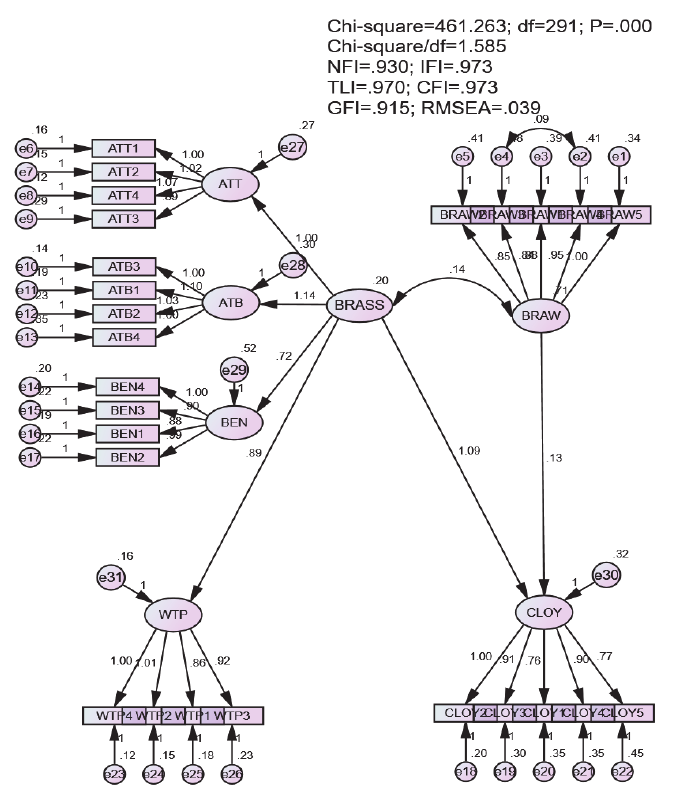
Fig. 3. Structural model with Unstandardized Estimates